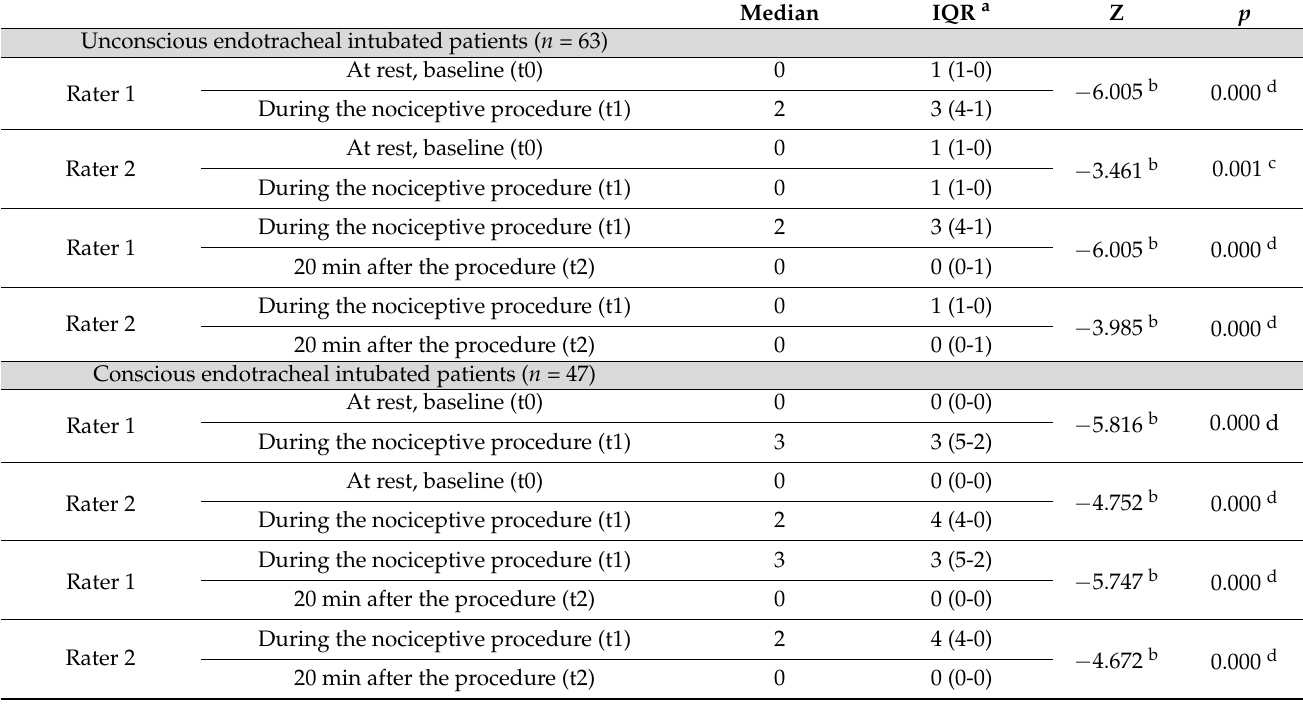
Table 1. Critical-Care Pain Observation Tool scores recorded at each time point by Rater 1 and Rater 2 in unconscious and conscious mechanically ventilated patients.